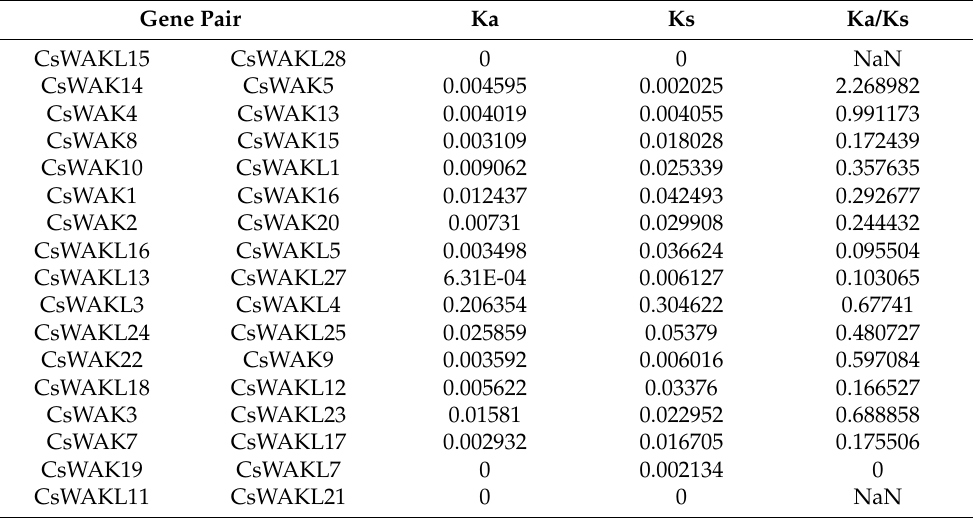
Figure 4. Chromosomal distribution of 23 WAK/WAKL genes in Cannabis sativa. Chromosome numbers are shown beside each chromosome. Colors of genes were obtained from the phylogenetic tree. Table 2. Selective pressure analysis.